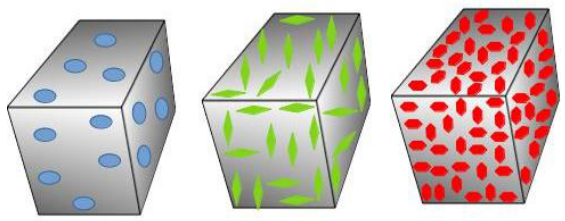
Figure 1. Representation of random insulating grain distributions in a conducting